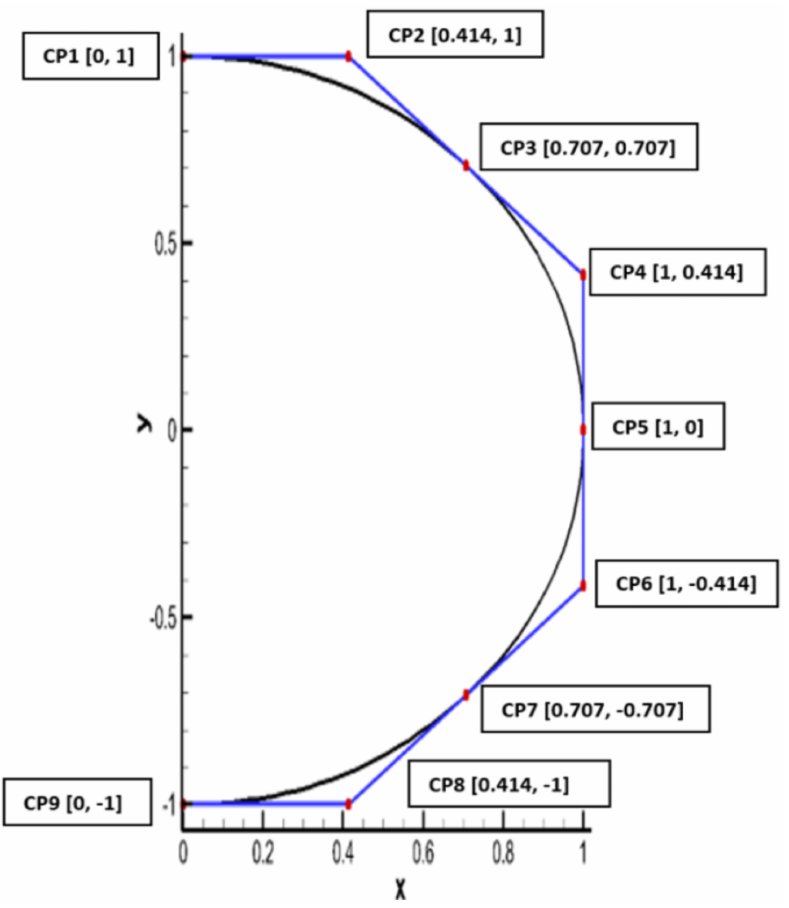
Figure 2. Cross section definition using B − spline